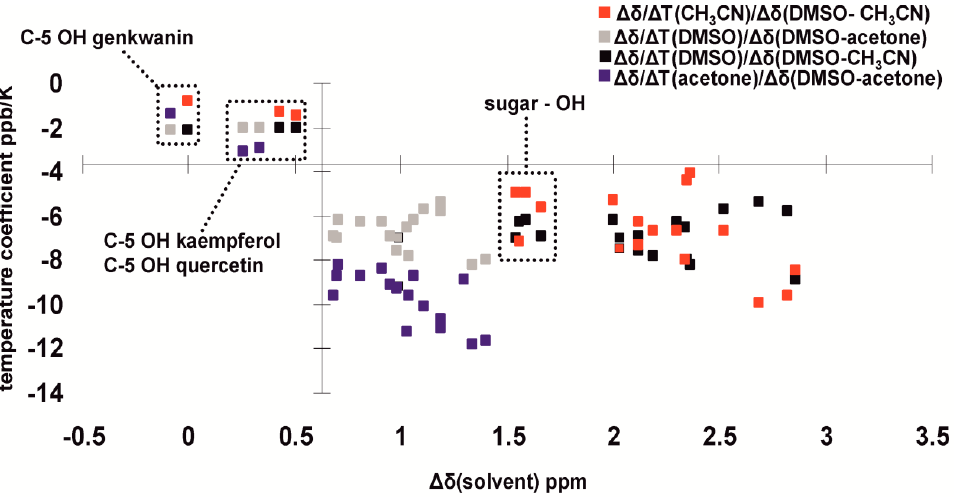
Figure 26. Correlation between the OH temperature coefficient and chemical shift differences in different solvents (DMSO- d of oleuropein, hydroxytyrosol, quercetin, kaempferol and genkwanin. The C-5 OH protons of the flavonoids implicated in intramolecular hydrogen bonding are well clustered in the upper left corner of the graph. Reprinted with permission from [25]. Copyright 2013, The Royal Society of